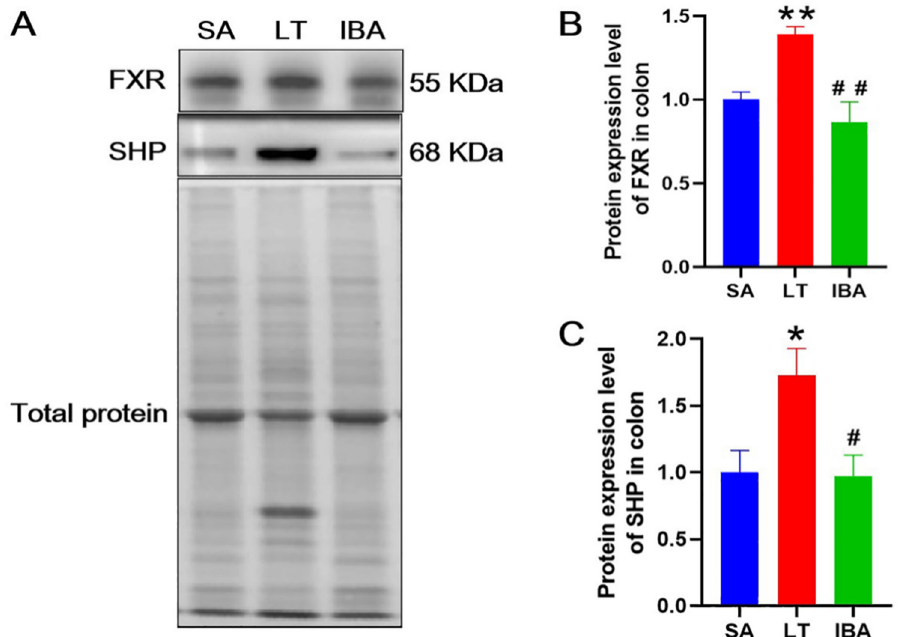
Figure 12. ( A ) Representative immunoblot images of FXR and SHP proteins in colon tissue of Daurian ground squirrels. ( B ) Statistical graph of protein expression level of FXR (farnesoid X receptor). ( C ) Statistical graph of protein expression level of SHP (small heterodimer partner). SA, summer active; LT, late torpor; IBA, interbout arousal. Mean ± SEM. n = 3. Compared with SA group, * p < 0.05, ** p < 0.01. Compared with LT group, # p < 0.05, ## p < 0.01.